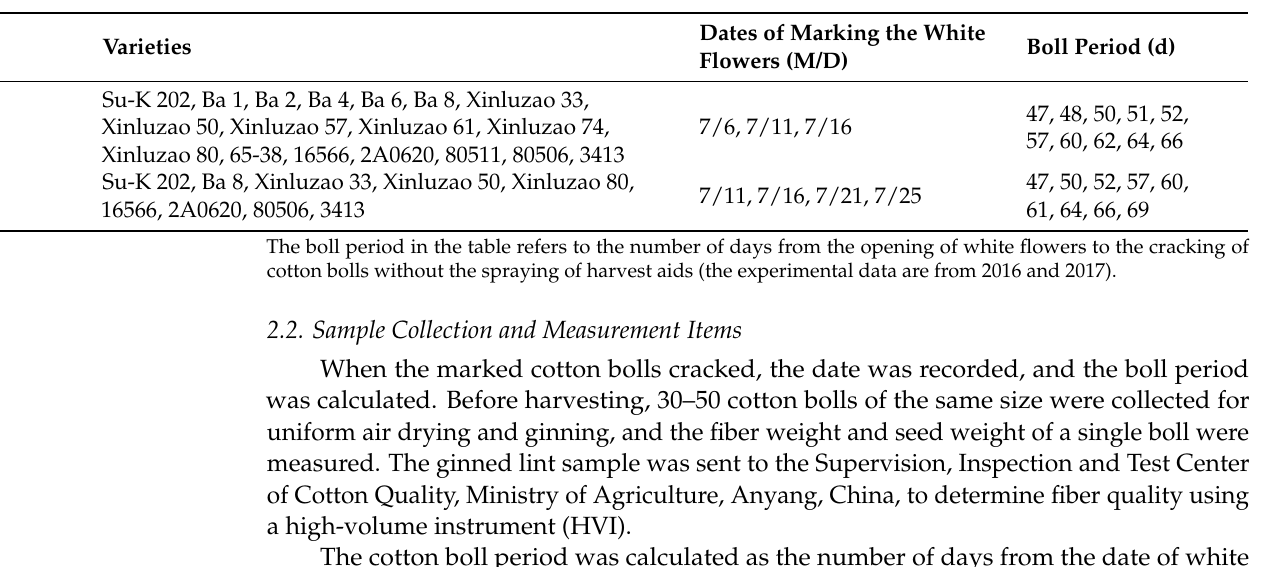
Table 1. Tested varieties, dates of marking the white flowers, and boll period.